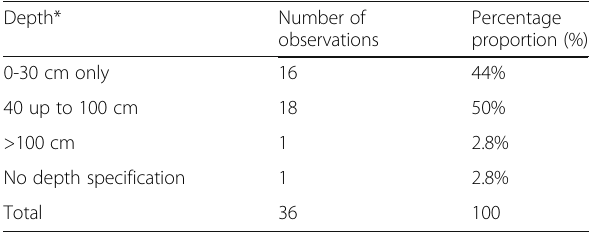
Table 3 Various depths reported in referred articles